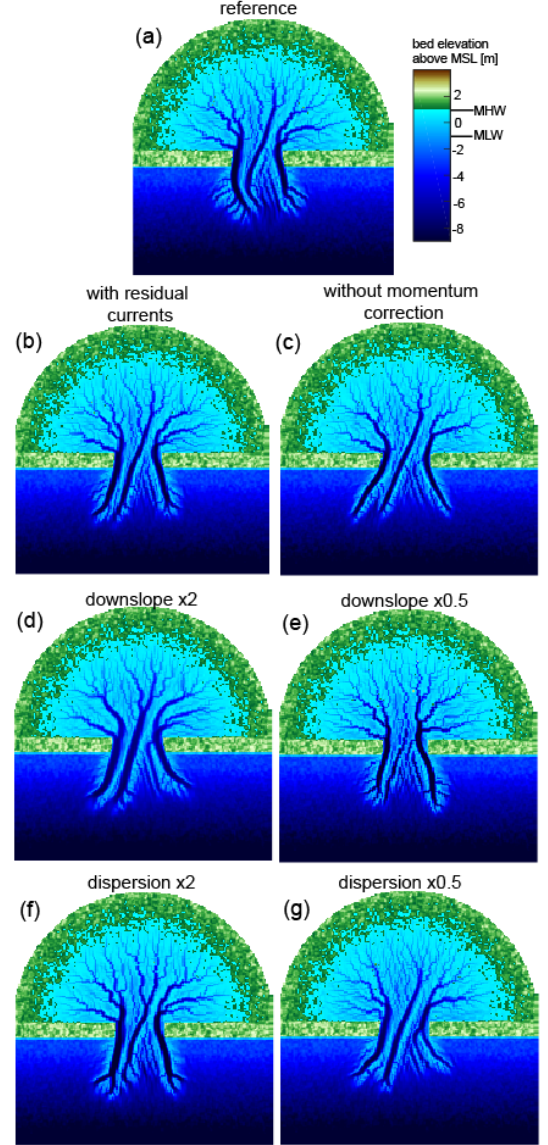
Figure 8. Sensitivity analysis of CM2D with respect to different parameters. All simulations are compared at year 500 (Figure 5e). ( a ) Reference scenario (as in Figure 5e); ( b ) Scenario in which the residual currents (Equation (14)) are included in the sediment transport (Equation (11)); ( c ) Scenario without the correction for the inertial term (Equation (4)) in the hydrodynamic model (Equations (2) and (3)); ( d , e ) Scenarios with different values of the downslope coefficient; ( f , g ) Scenarios for different values of the tidal dispersion coefficient.